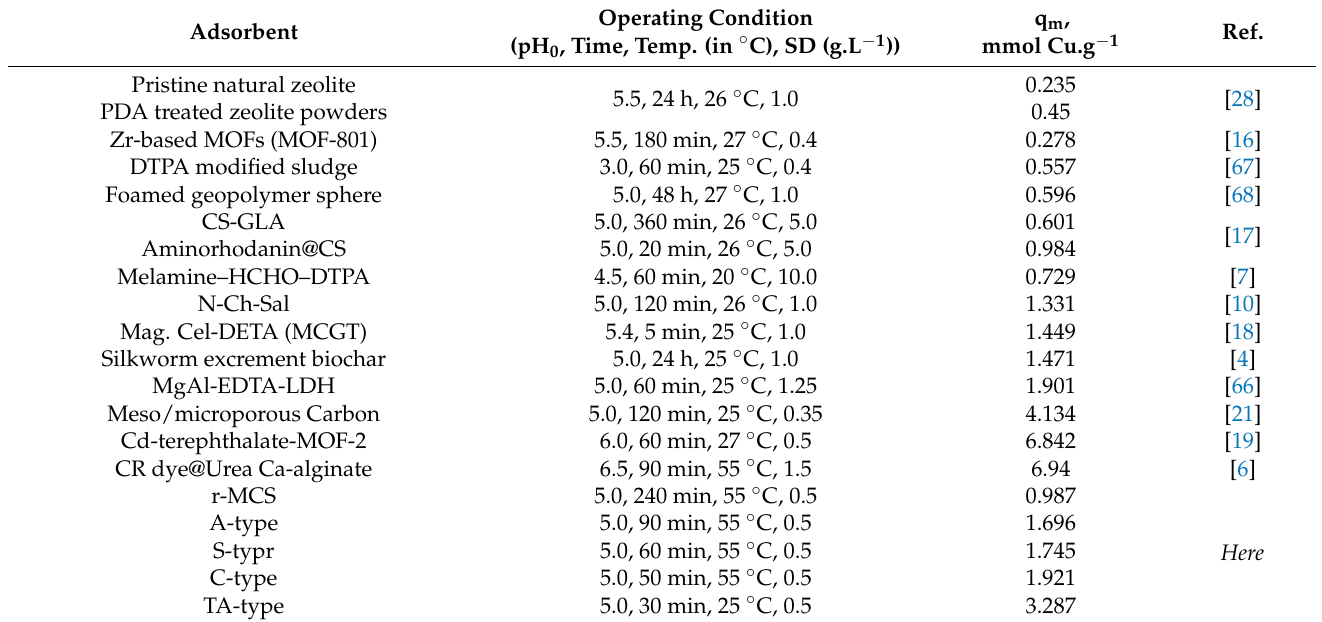
Table 1. Copper adsorption performances using different